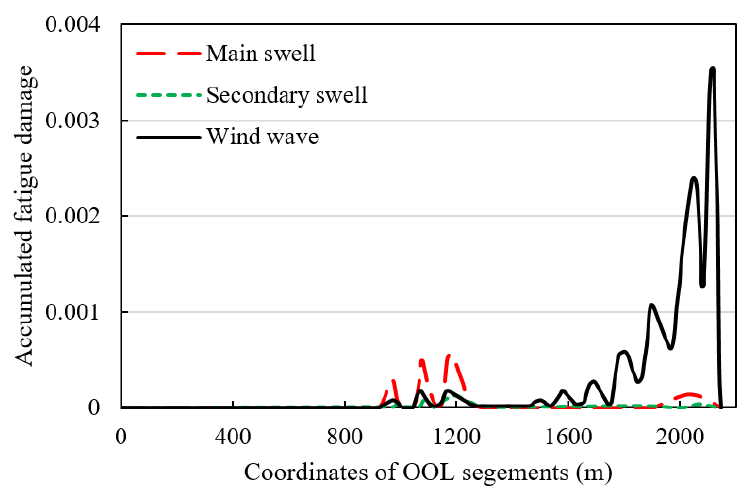
Figure 12. Fatigue damage of OOL under different wave conditions.